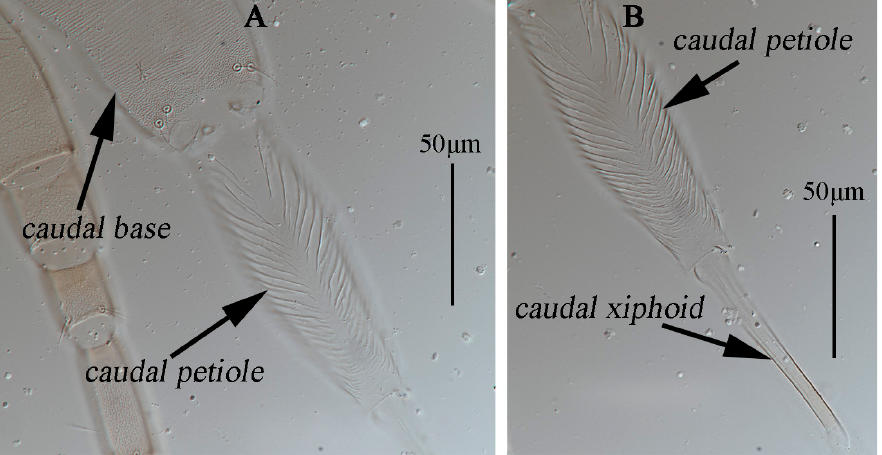
Figure 5. Cunaxicaudus mohanensis sp. nov . (male). ( A )—Ventral caudal base and petiole (photo). ( B )—Ventral caudal petiole and xiphoid (photo). Scale bar = 50 µm.